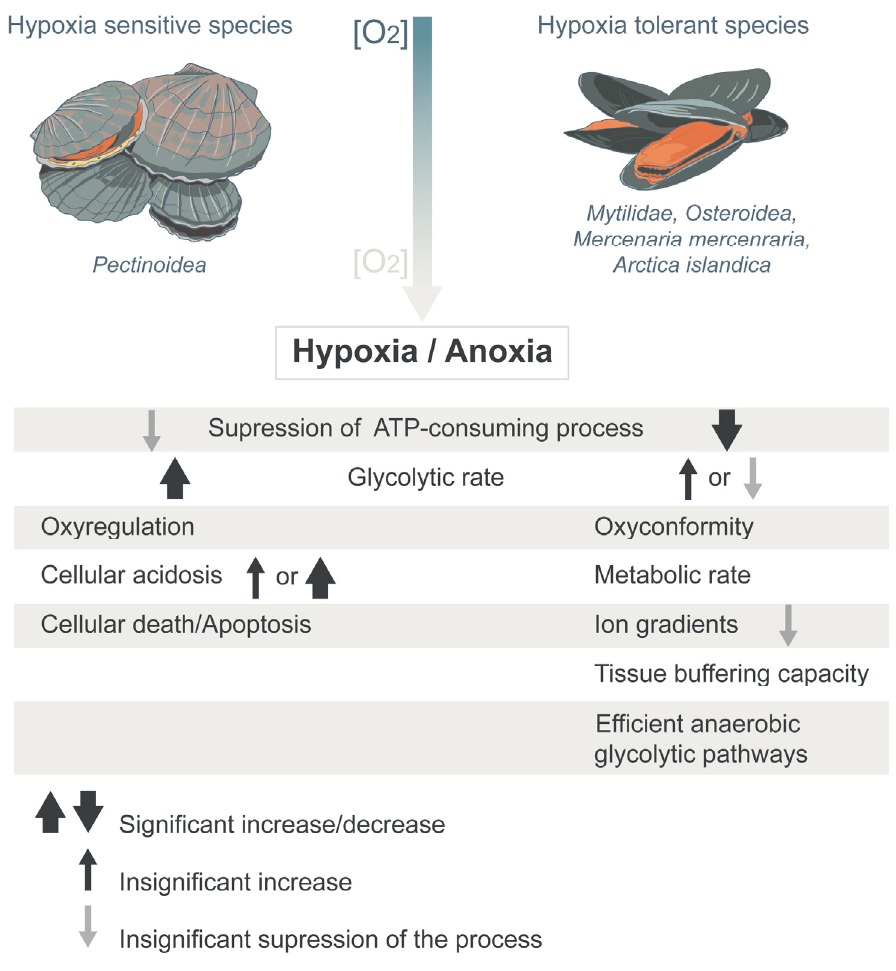
Figure 1. Division of marine bivalves on the basis of their metabolic response to hypoxia and the differences in the molecular mechanisms of their tolerance to low-oxygen conditions.